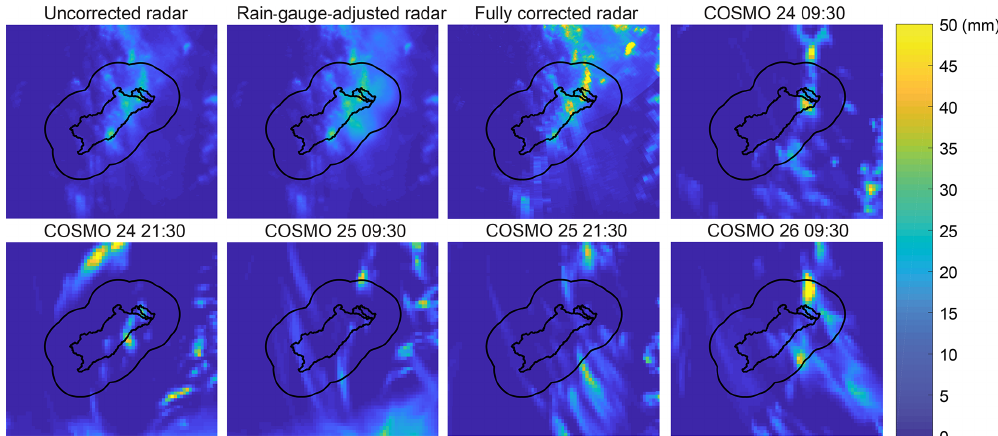
Figure 9. Total rain depth for 26 April, 06:00 to 24:00, using different degrees of corrections for the radar data (three upper-left panels) and various COSMO runs (COSMO titles refers to the timing of forecast availability). The outlines of the Zin and Zafit basins are depicted, as well as a 20km buffer zone around the Zin